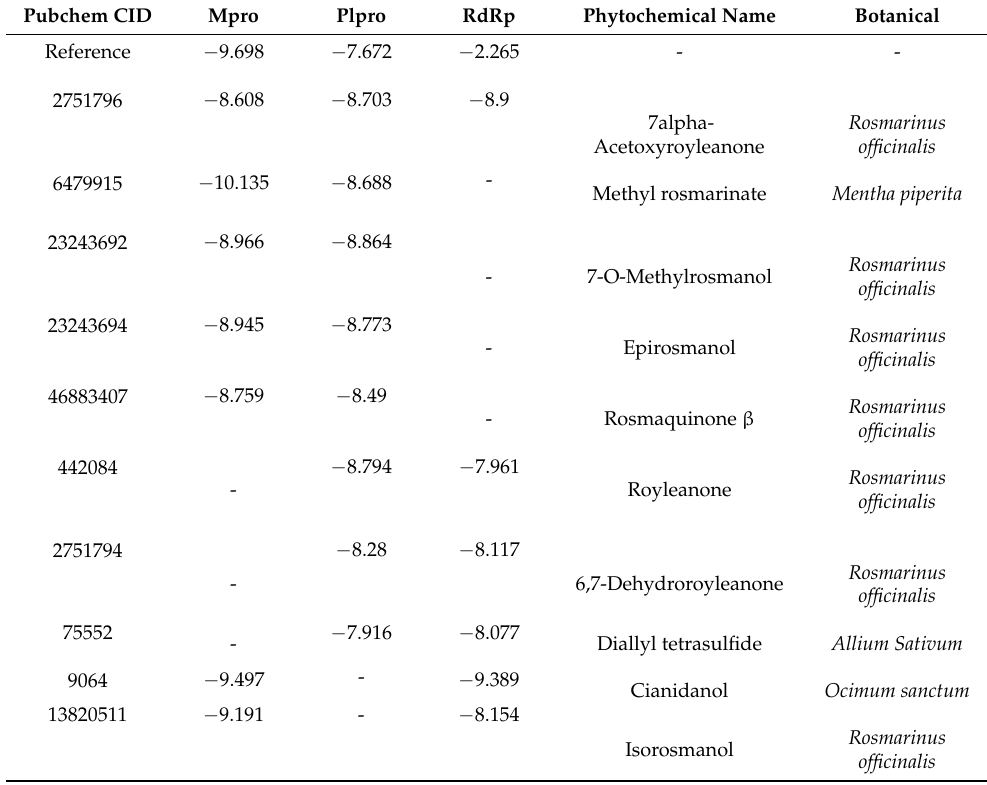
Table 1. Comparison of top ligands to identify common inhibitor against the target